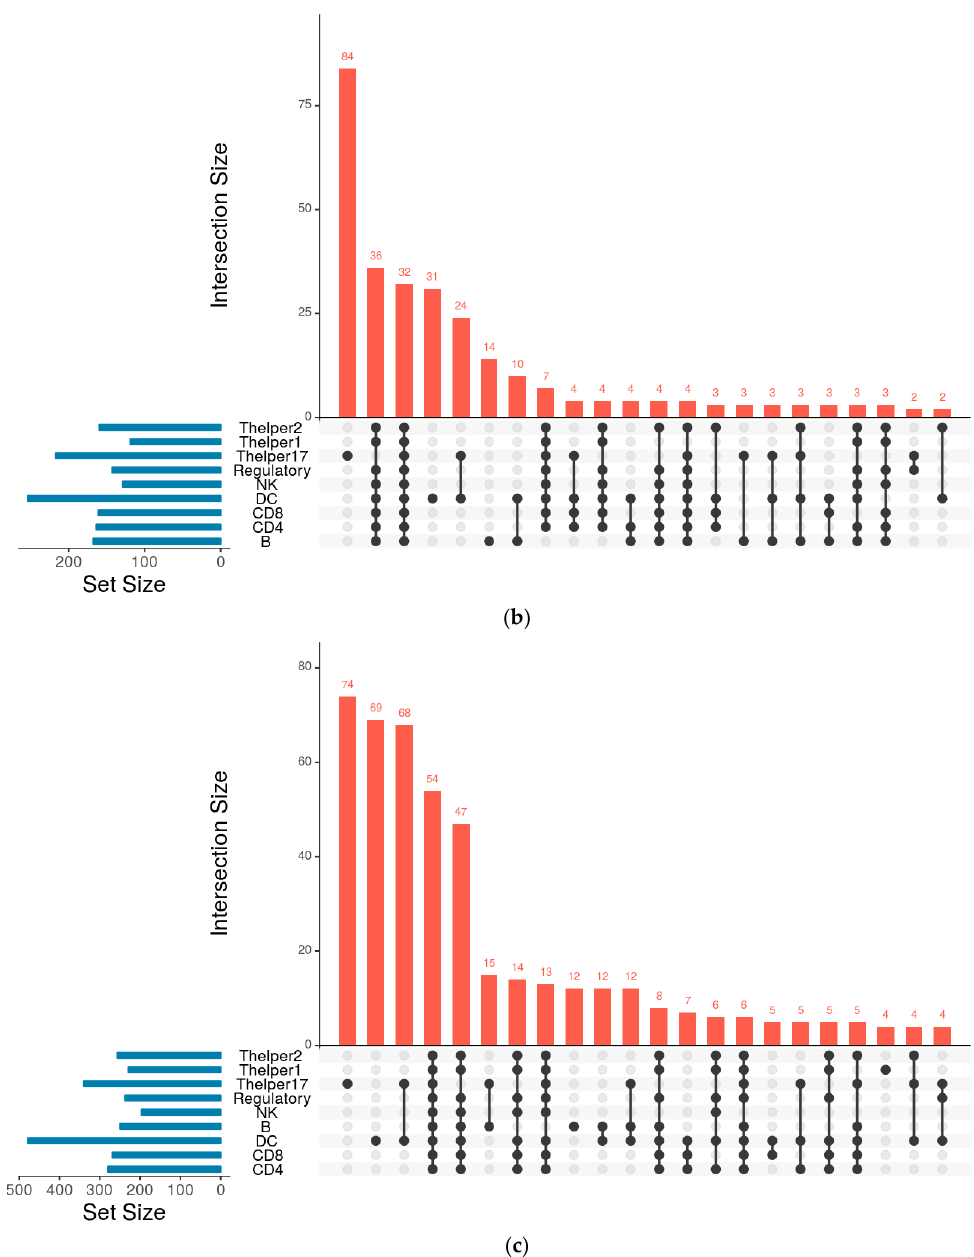
Figure 1. Unique and overlapping genes, receptors, and transcription factors (TFs) between immune cells. The figure reveals the number of genes that are unique to each cell subset or common across different cell types/subsets. The red histogram represents the size of the elements that are present in the relation, which is depicted as the black dots between the cell types (it is of note that elements with low numbers have not been depicted), while the blue bar graph specifies the total number of elements that are present in each set. ( a ) The intersections and unique genes for all the cell types; ( b ) The variations of transcription factors across all the immune cell types; ( c ) The common and unique receptors across all the immune cell types.